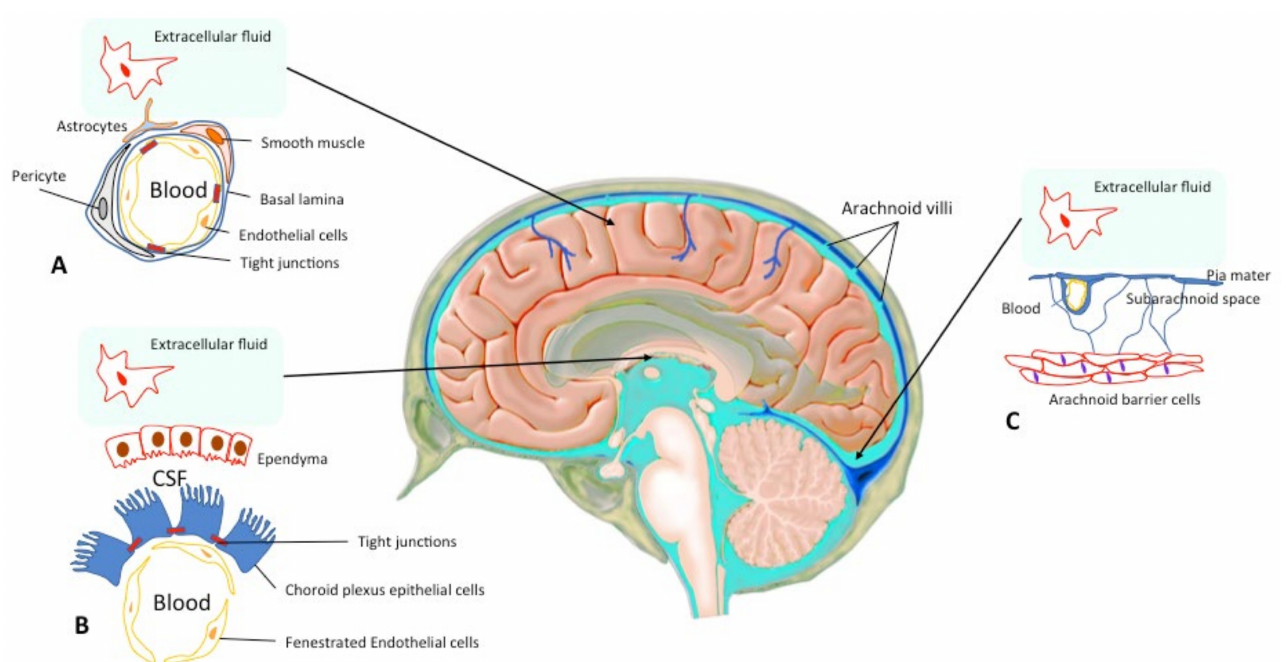
Figure 1. Central Nervous System Barriers. The blood–brain barrier (BBB) is present between the cerebral capillaries and the brain parenchyma ( A ). Endothelial cells with tight junctions, basal lamina, pericytes and astrocyte endfeet separate the blood compartment from the extracellular fluid. The blood–cerebrospinal fluid (CSF) barrier lies at choroid plexus in the lateral, 3rd, and 4th ventricles of the brain ( B ). The arachnoid barrier ( C ), close to the sagittal sinus, is formed by a multilayer epithelial structure with tight junctions. Arachnoid villi cross the dura, project into the sinus, and drain CSF into the blood (according to Abbott et al. 2010; Haines DE 1991